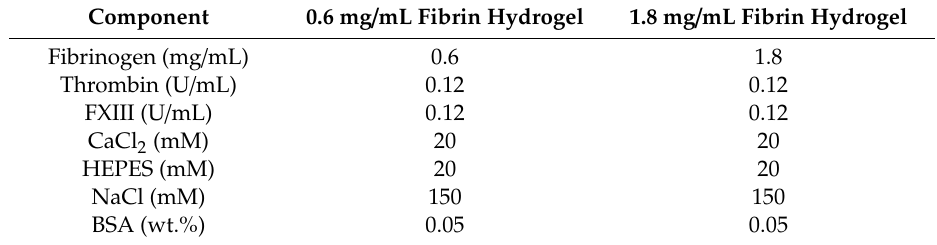
Table 1. Final concentrations for hydrogels with two di ff erent starting fibrinogen